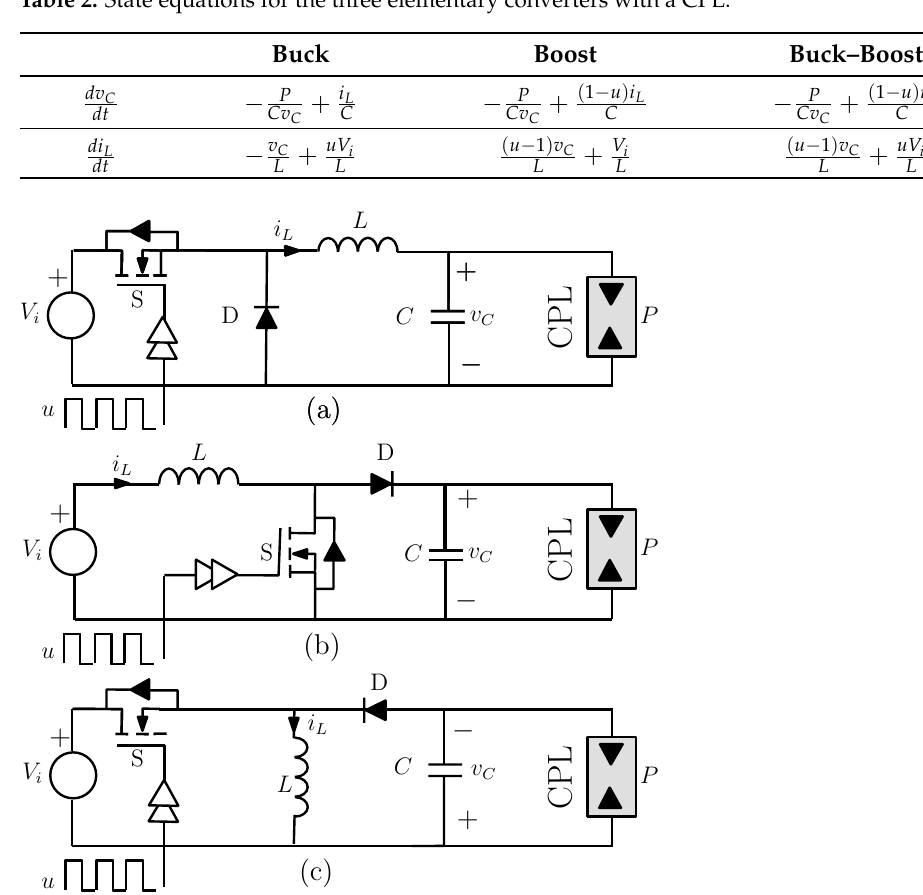
Figure 5. Elementary switching converters loaded by a CPL: ( a ) buck, ( b ) boost, and ( c )